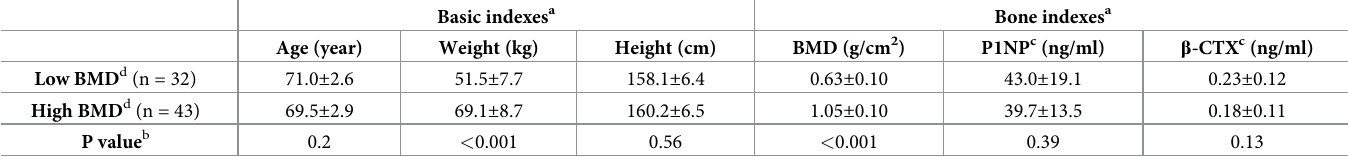
Table 2. Basic characteristics of the study Sample